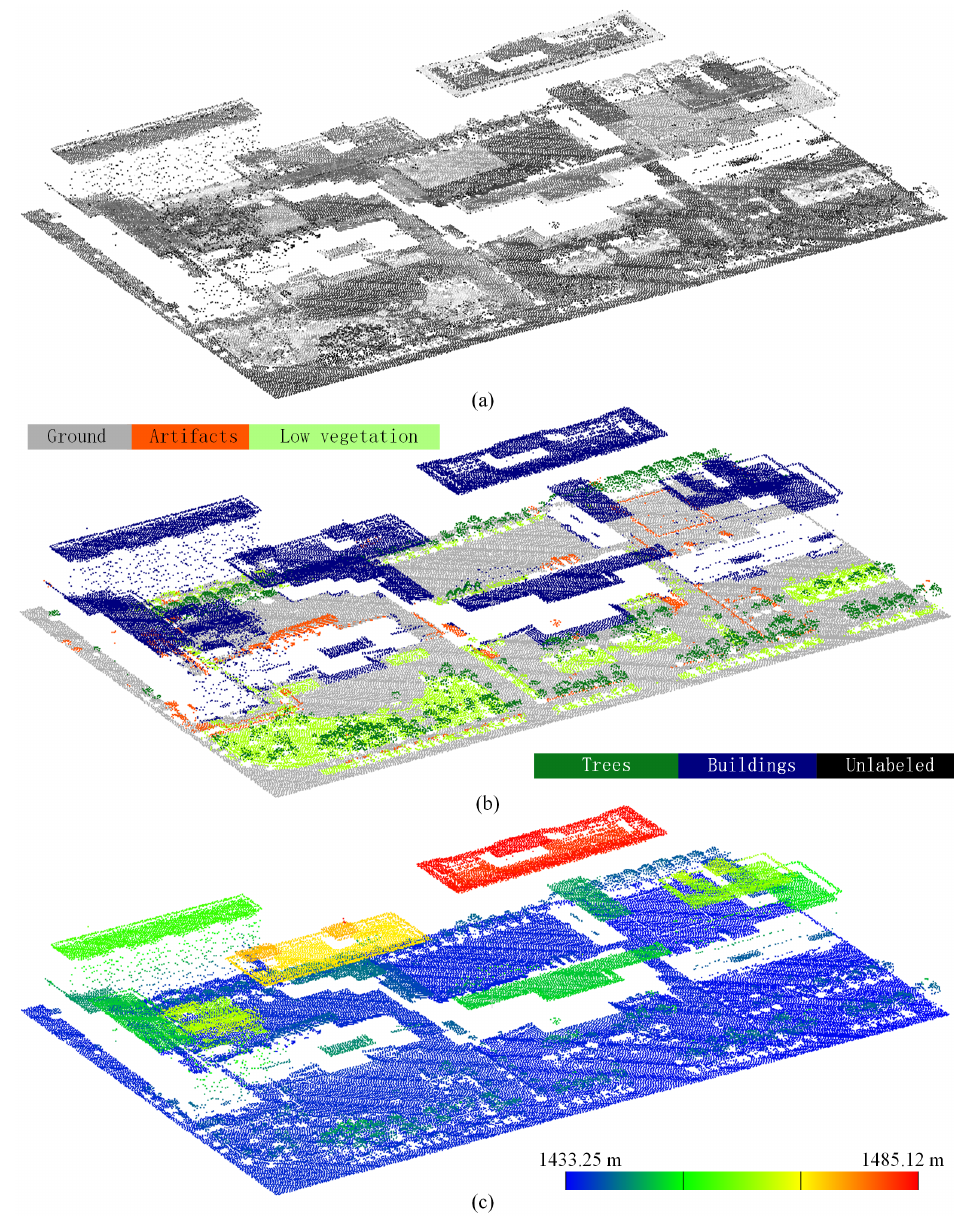
Figure 1. An example part of the presented airborne laser scanning (ALS) dataset. ( a ) Points with natural intensities. ( b ) Annotated points with different labels. ( c ) Points rendered with height